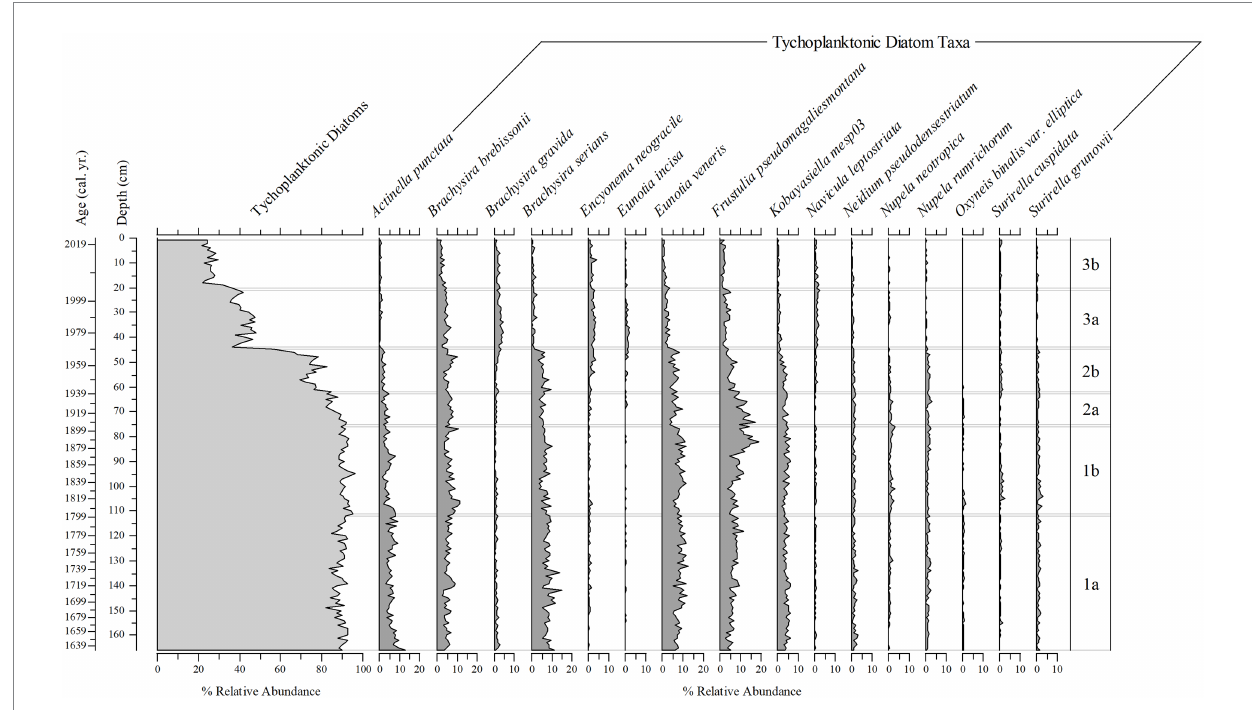
FIGURE 10 Stratigraphic plots of the percent relative abundance of tychoplanktonic diatom taxa, and the percent relative abundance of 16 tychoplanktonic diatom taxa (from 202 taxa) found throughout the 166 cm (1633–2019) sediment core.